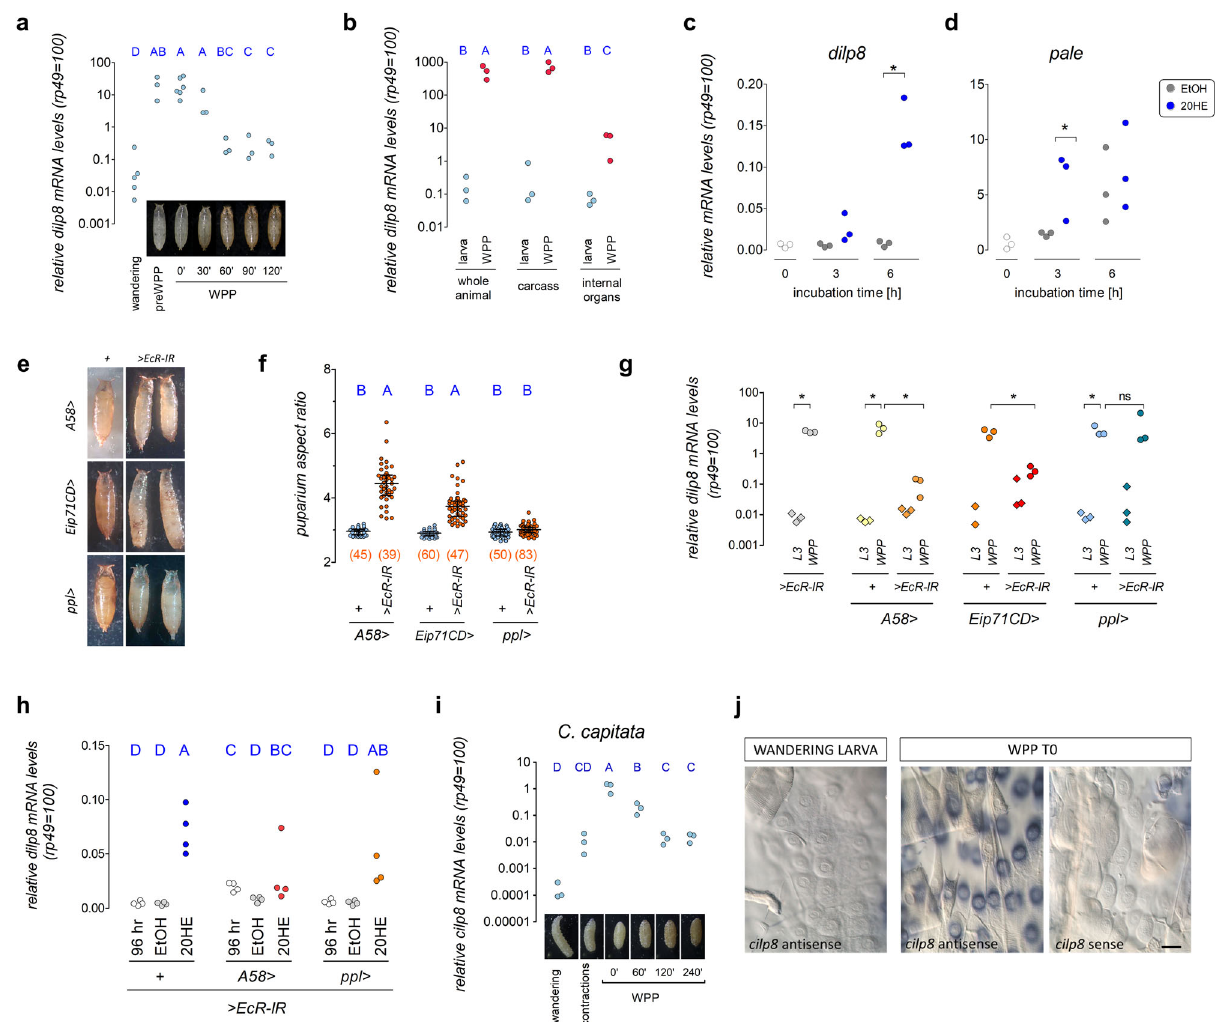
Table 2): a , b , c , d , g – i Dots: biological repeats f Dots: one animal. Horizontal bar, median. Error bars: 25-75% percentiles. a , b , f , h , i Same blue letter, P